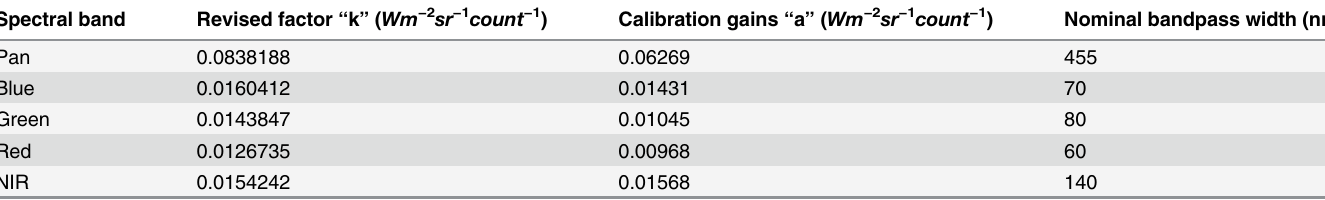
Table 2. Calibration coefficients for absolute radiance conversion of 16-bit QuickBird images 1)